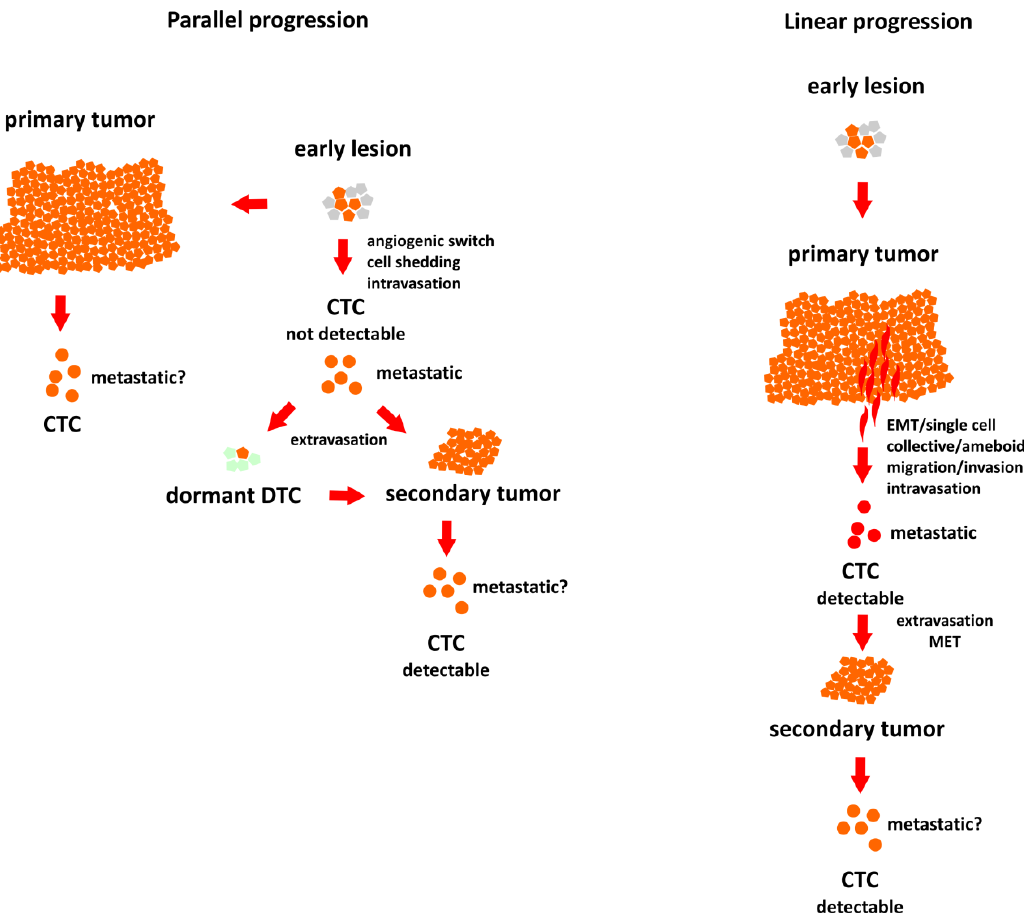
Figure 1. Two different models of breast cancer progression. In the parallel progression model dissemination occurs early and the metastatic circulating tumor cells (CTCs) are impossible to detect with the current sensitivity of the methods. In linear progression model metastatic CTCs are detectable before actual progression occurs.